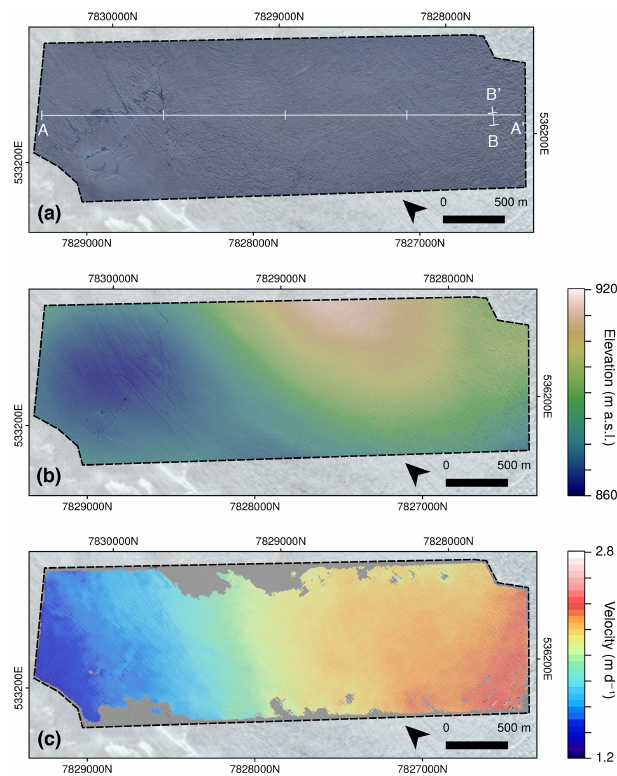
Figure 7. Example data output from the ice sheet interior. (a) The 0.15m orthophoto collected at 15:15WGST 22 July 2017. (b) The 0.2m DEM from the same flight. (c) Velocity field ( σ v = ± 0 . 05m) from 15:15WGST 22 July to 19:30WGST 26 July